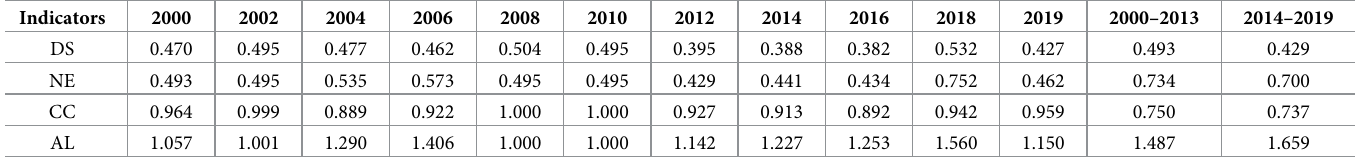
Table 1. Statistical results of overall